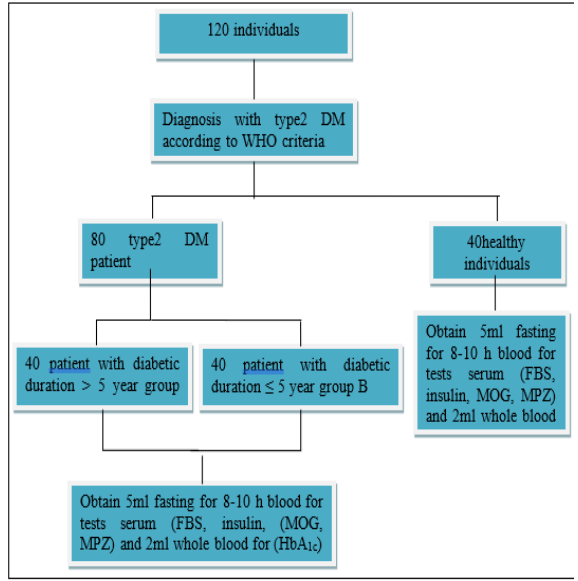
Figure 1: Study design Statistical analyses: The Statistical Package for Social Science (SPSS) version 27.0 was